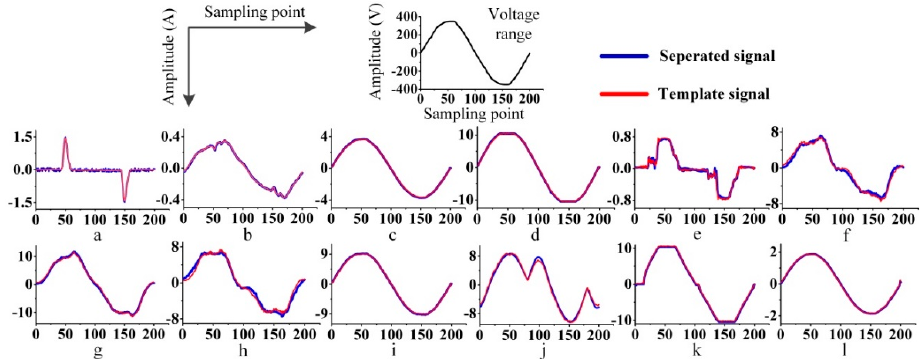
Figure 6. Comparison diagram of the separated load current and the template current.